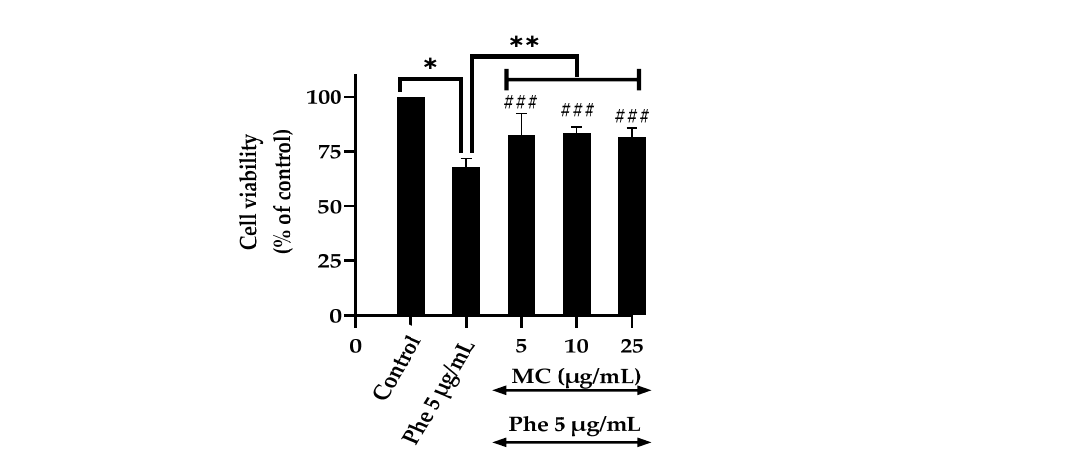
Figure 2. Cytoprotective effect of MC against PAHs-induced neurotoxicity. Cell viability of HT-22 cells treated with 5 µ g/mL Phe alone or co-treatment with different concentrations of MC for 48 h; ( n = 3; * p < 0.05 vs. control (0 µ g/mL Phe); ** p < 0.05 vs. Phe alone; * p value was 0.000 in 5 µ g/mL Phe alone and ** p values were 0.002, 0.001, and 0.006 in Phe combined with 5, 10, and 25 µ g/mL MC groups, respectively; ### p value was 0.000, 0.001, and 0.000 in Phe group combined with 5, 10, and 25 μ g/mL MC compared with control group, respectively.